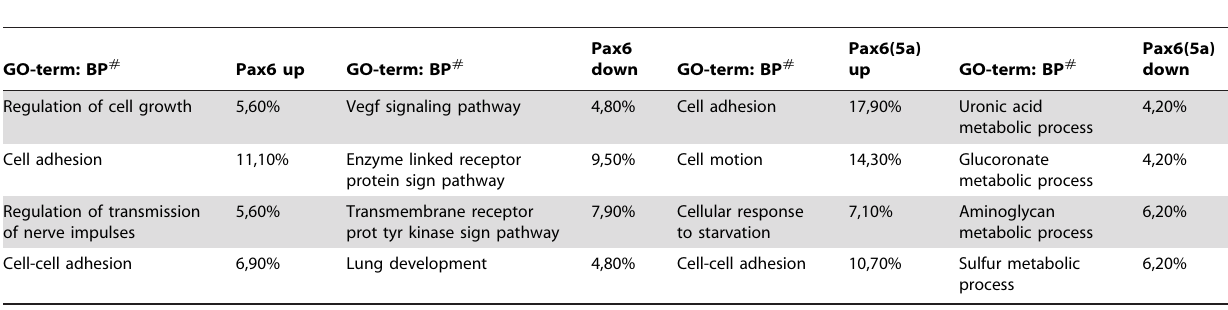
Table 4. Percentage of Pax6/Pax6(5a) up- or downregulated genes associated with various Biological Property (BP) gene ontology